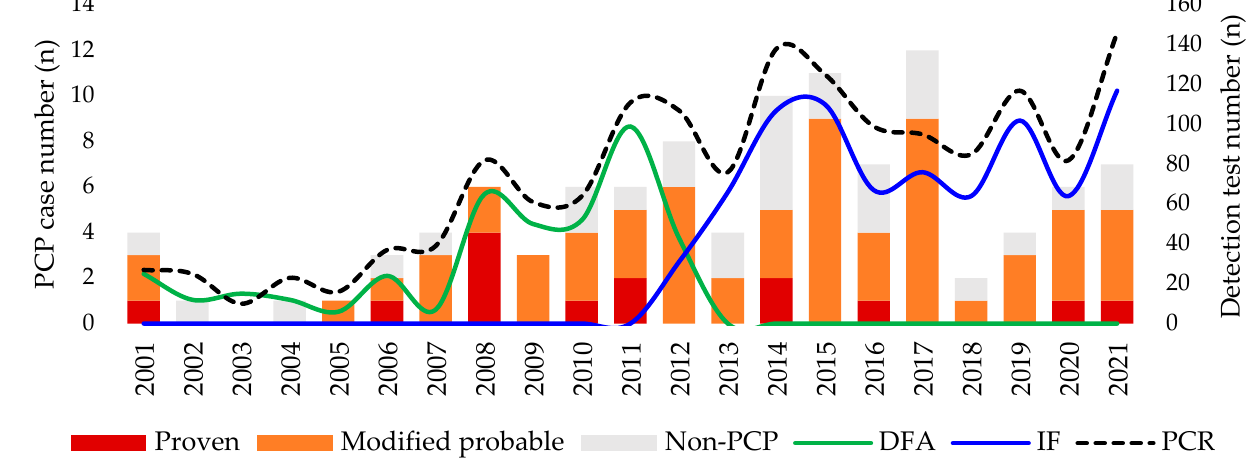
Figure 1. Annual number of Pneumocystis jirovecii testing performed and clinical PCP diagnosis. PCP, Pneumocystis jirovecii pneumonia; n , number; DFA, direct fluorescent antibody; IF, immunofluorescence; PCR, polymerase chain reaction.